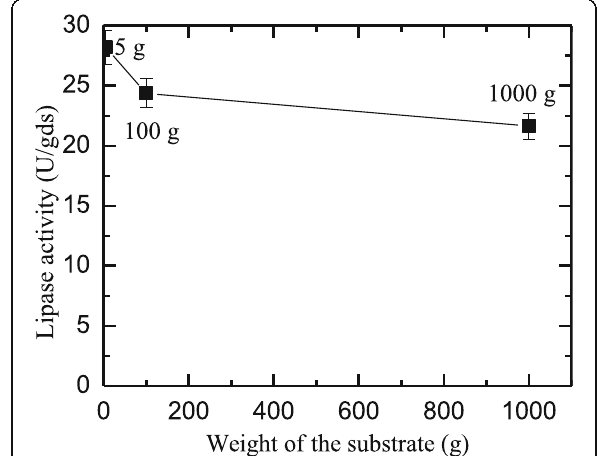
Fig. 4 Scale-up of lipase production in flask and tray bioreactor at optimum